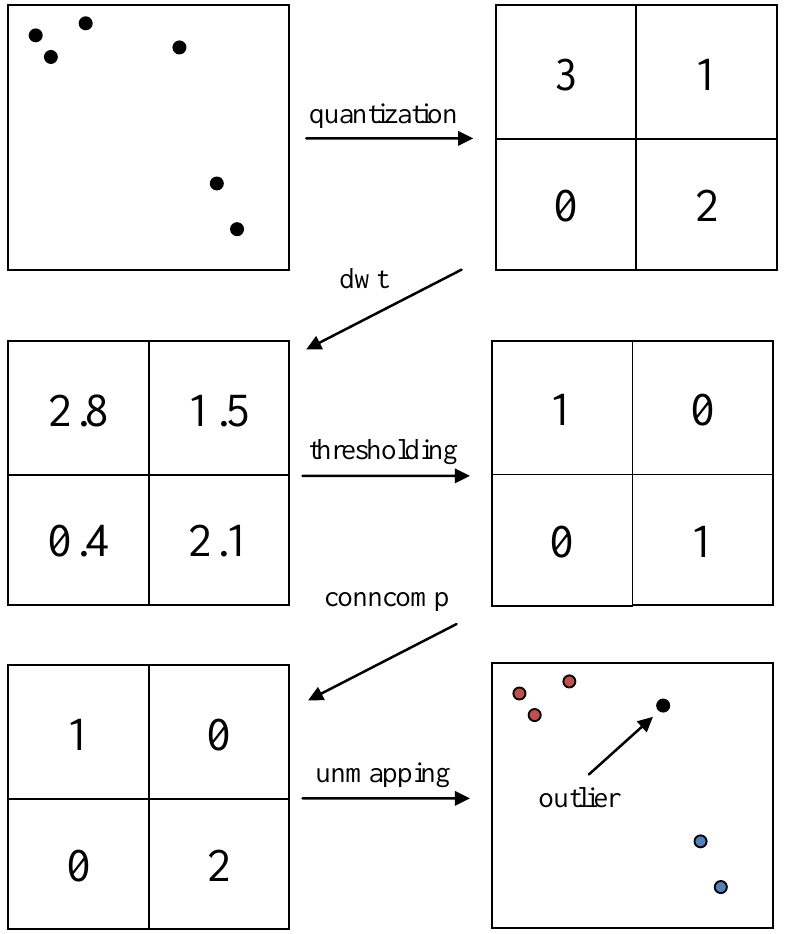
Figure 2. Illustrated step-by-step operation of the WaveCluster